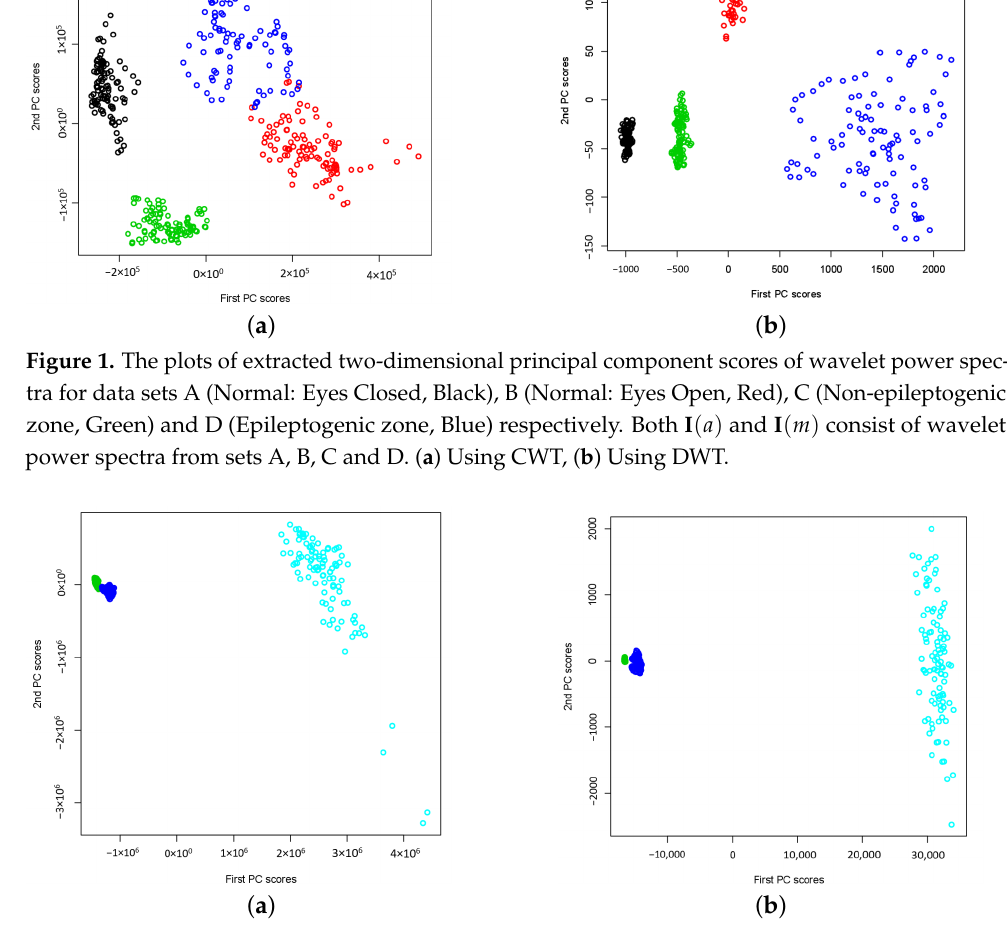
Figure 2. The plots of extracted two-dimensional principal component scores of wavelet power spectra for data sets C (Non-epileptogenic zone, Green), D (Epileptogenic zone, Blue) and E (Seizure on set, Light Blue) respectively. Both I ( a ) and I ( m ) consist of wavelet power spectra from sets C, D and E. ( a ) Using CWT, ( b ) Using